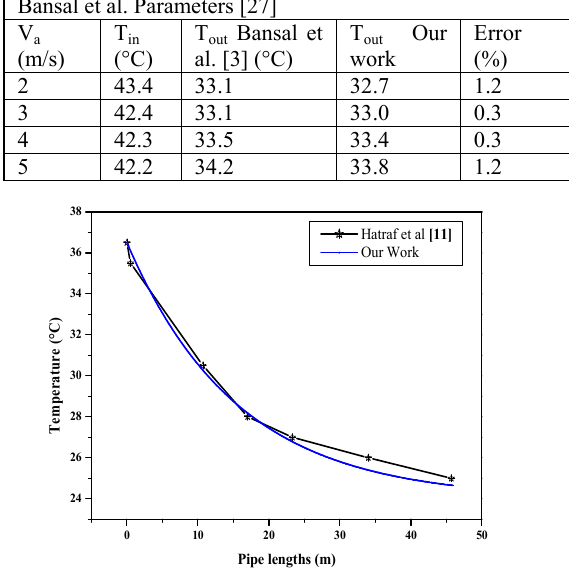
Figure 3. Validation of air temperature in the buried pipe against Hatraf et al. [28]. The detailed input parameters for the comparisons